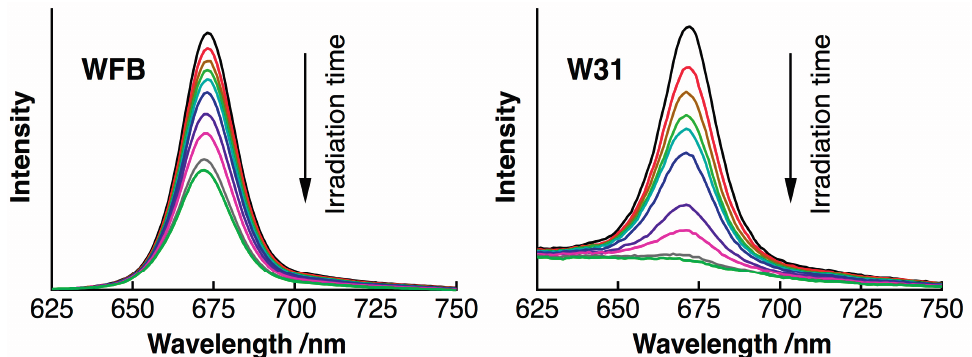
Figure 2. Time dependence of fluorescence spectra of TPS in WFB ( left ) and W31 ( right ) cells with irradiation of 405-nm light in air. The irradiation times were 0, 1, 2, 3, 4, 6, 10, 15, 25 and 30 min. The concentration of TPS in the culture solution was 100 μ M.